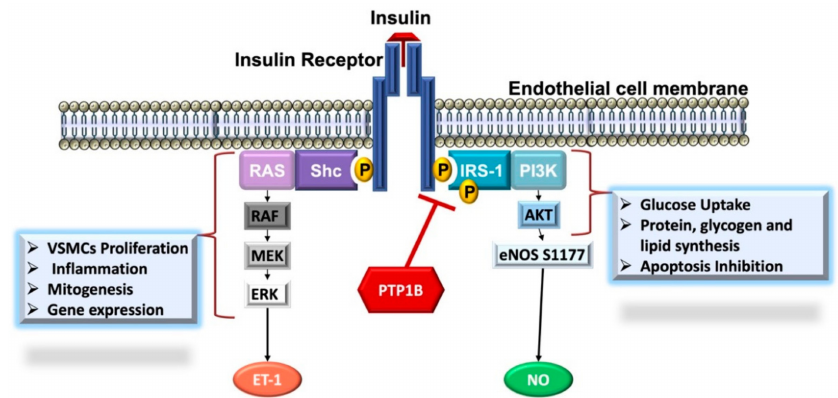
Figure 2. Insulin-mediated vascular actions. Insulin exerts vasodilatory and vasoconstricting actions in endothelial cells. Phosphatidylinositol-4,5-bisphosphate 3-kinase (PI3-K) branch of insulin signaling results in the phosphorylation (Ser1177) and subsequent activation of endothelial NO synthase (eNOS) stimulating NO production and release to induce vasodilation. Conversely, mitogen-activated protein kinase (MAPK) branch stimulates the production of endothelin-1 (ET-1) resulting in vasoconstriction. The negative regulatory actions of protein tyrosine phosphatase 1B (PTP1B) on insulin signaling response are indicated. Abbreviations: ERK, Extracellular signal-regulated kinases; MEK, MAPK